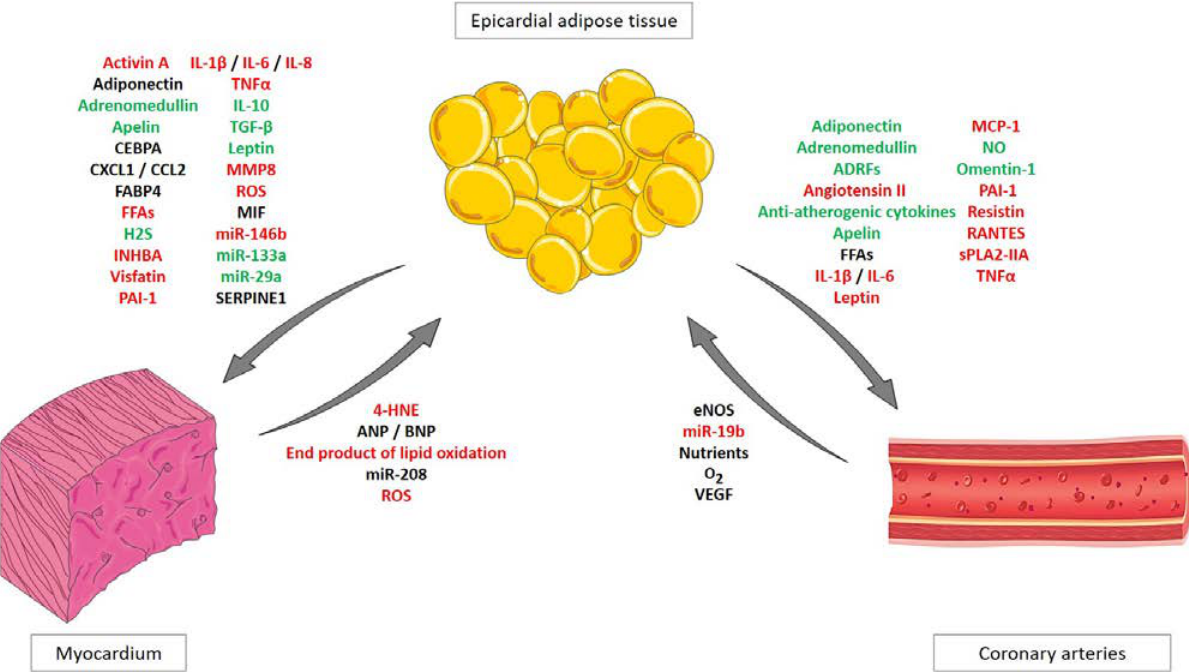
Figure 1. The crosstalk between epicardial adipose tissue and the cardiovascular system. A local crosstalk takes place between EAT (epicardial adipocytes and other EAT composing cells) and the cardiovascular system (e.g., myocardium and coronary arteries). Physiological and pathophysiologi- cal signals such as cytokines, adipokines or fibrokines can be released from EAT to cardiomyocytes (and from myocardium to EAT) or coronary artery endothelial cells (grey arrows). Theses cytokines can have protective and/or beneficial effects (green) or harmful effects (red). Other molecules’ effects are still not well established or are controversial